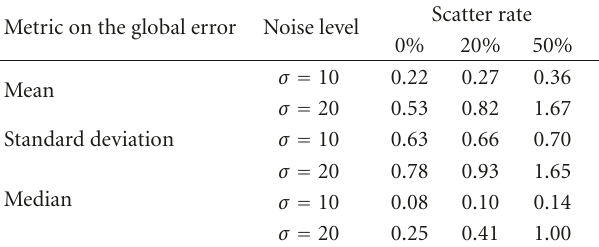
Table 2: Performance evaluation of the proposed method for di ff erent noise levels and scatter rates: average, standard deviation and median value (in pixels) of the global error computed over 250 generated image sequences.